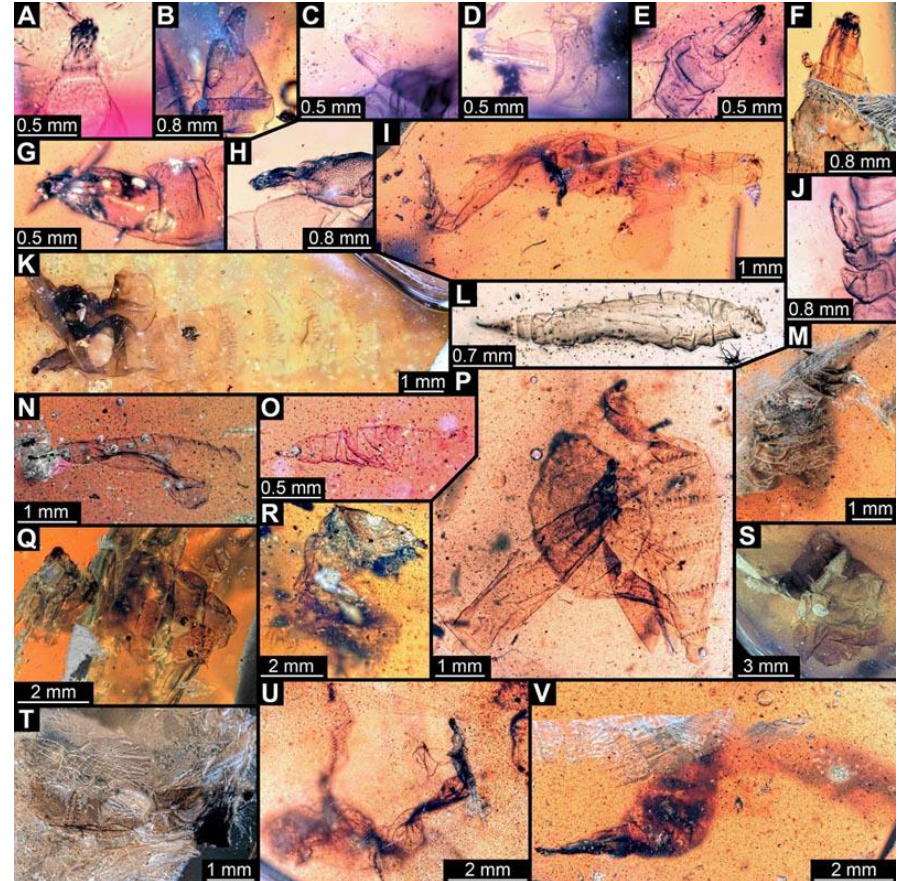
Figure 12. Several fossil larvae. ( A ). PED 0567-2. ( B ). PED 0681. ( C ). PED 0773-1. ( D ). PED 0773-2. ( E ). PED 0773-3. ( F ). PED 0811-1. ( G ). PED 0764. ( H ). PED 0811-2. ( I ). PED 0978. ( J ). PED 1200-3. ( K ). PED 1353. ( L ). PED 1535. ( M ). PED 0614. ( N ). PED 1548-1. ( O ). PED 1548-2. ( P ). PED 0799. ( Q ). PED 0678. ( R ). PED 0738. ( S ). PED 0760. ( T ). PED 0712. ( U ). PED 0927. ( V ). PED 0777. (79) PED 0681: Specimen torn apart and partly scattered in the amber piece (Figure 12B). Surface structure apparent. Head capsule well preserved, still attached to prothorax and mesothorax, this anterior region separated from the rest of the trunk. One anterior spiracle apparent on prothorax. Short spine-like setae on thorax segments well developed.